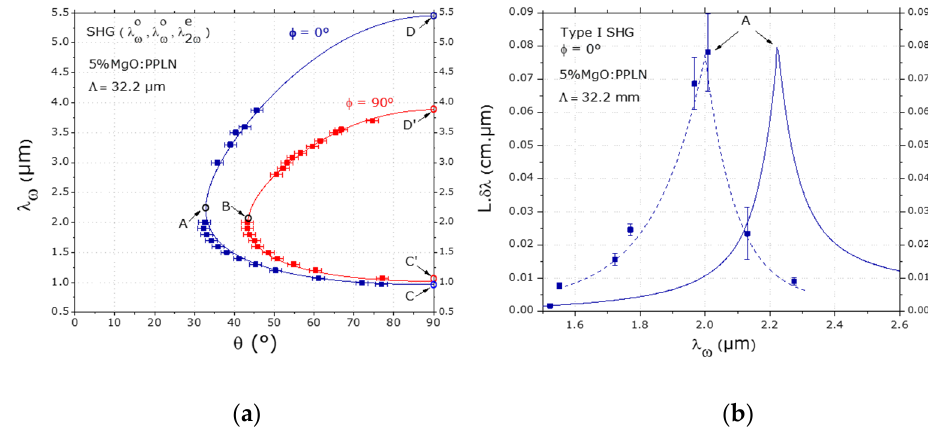
Figure 7. ( a ) Type I ( eoo ) SHG AQPM tuning curves of 5%MgO:PPLN ; the fundamental wavelength λ ω is given as a function of θ at φ = 0 ◦ and φ = 90 ◦ . ( o ) and ( e ) denote the ordinary and extraordinary polarizations, respectively. Dots stand for experimental data, and solid curves are the fits [17]. Vertical tangents of the curves at points A and B correspond to spectrally noncritical interactions. Points C, C ′ , D and D ′ are both BPM and AQPM directions since the grating has an infinite period φ = 90 ◦ . ( b ) Type I SHG AQPM spectral acceptances in the xy-plane as a function of the fundamental wavelength 𝜆 (cid:3104) . Dots stand for experimental data; the dotted curve is a guide for the eyes, and the solid curve corresponds to calculations from Sellmeier equations given in [17]. The maximum de- noted A, corresponds to the vertical tangent of the curve of ( a ).